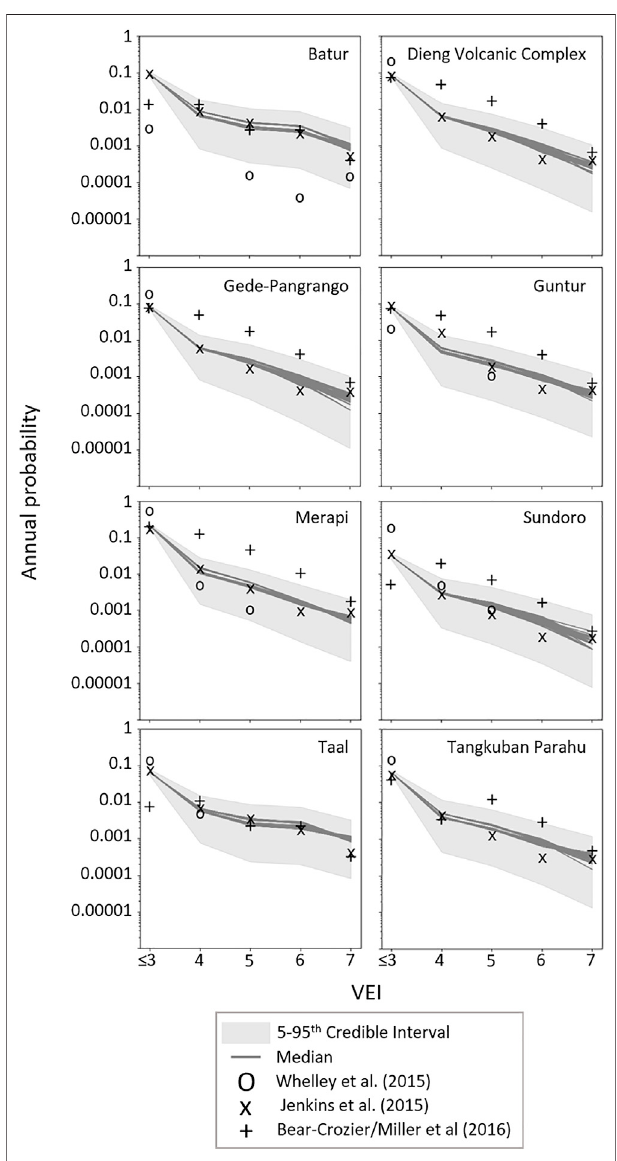
FIGURE 10 | Frequency-magnitude relationships from each of the iterations for case study volcanoes undergoing the Bayesian update compared to published point estimates from the literature (see Supplementary Material 1 for full reporting of published frequency- magnitude estimates for these volcanoes). Note: VEI are discrete data presented as continuous data to emphasize the relationship between VEI and annual